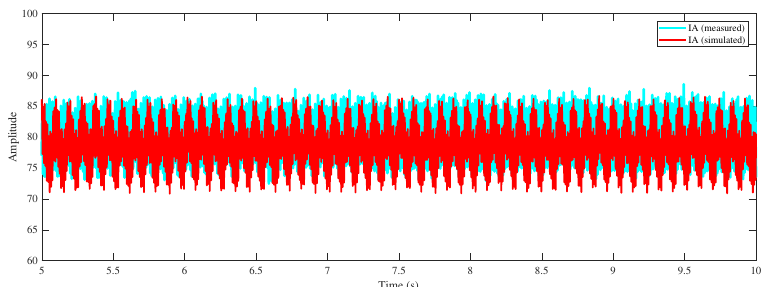
Figure 14. Simulated and measured IA ( t ) , from 5 to 6